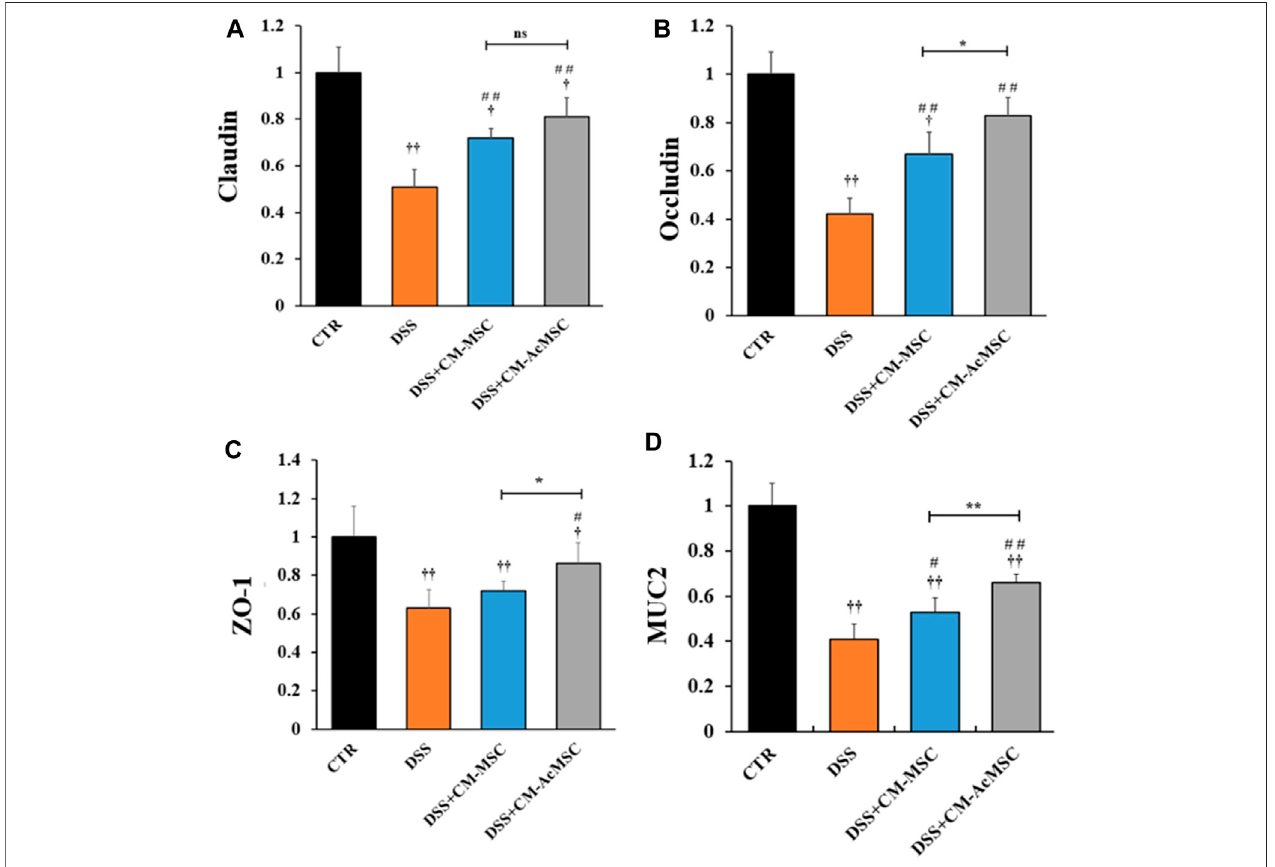
FIGURE 4 | CM-AcMSC enhanced the mRNA expression levels of tight junctions (Claudin, Occludin and ZO-1) and MUC2 in colon tissues, n (cid:2) 6. The mRNA expression levels determined by real time PCR, normalized by β -actin. (A) Claudin-1. (B) Occludin. (C) ZO-1. (D) MUC2. † p < 0.05, †† p < 0.01 vs CTR; # p < 0.05, ## p < 0.01 vs DSS; * p < 0.05, ** p <